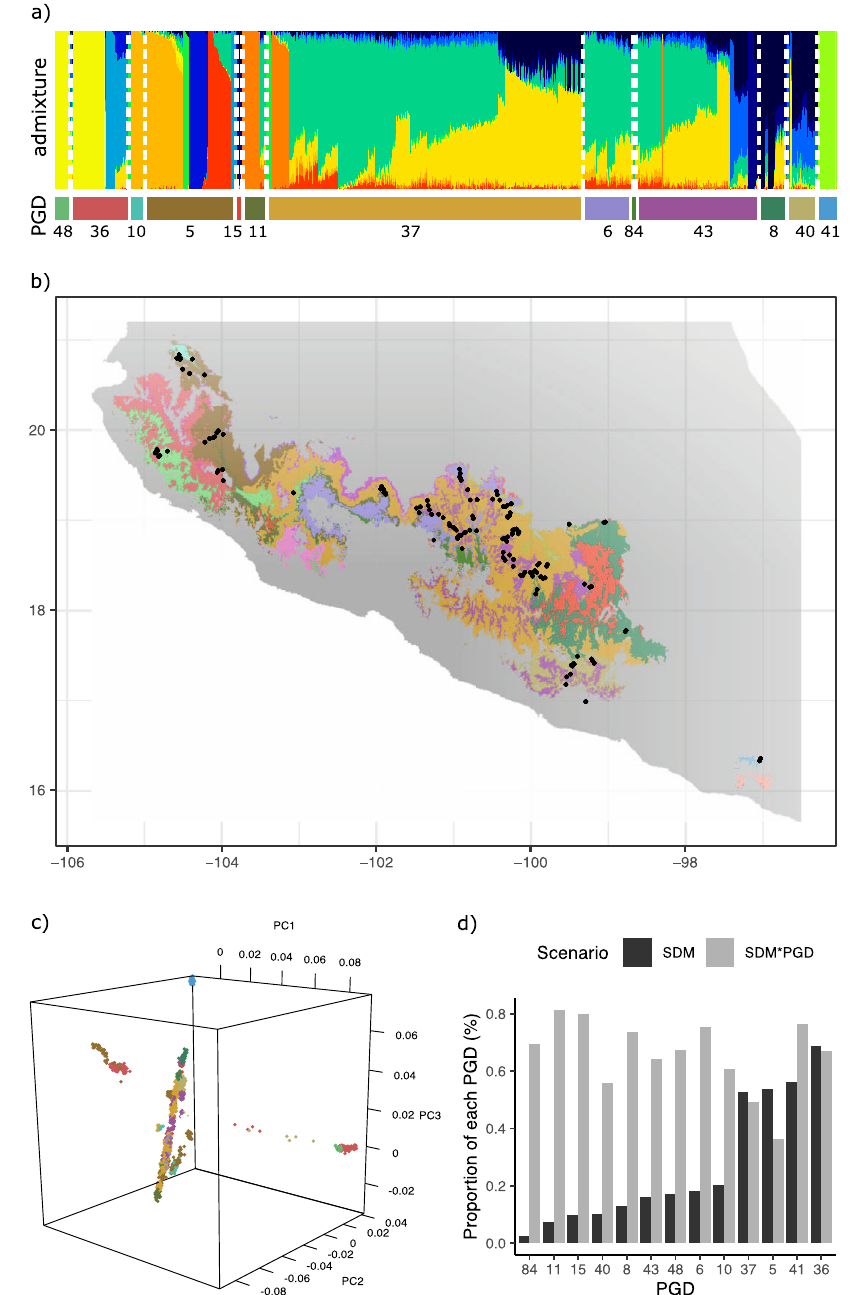
Fig. 3 | Genetic diversity of Zea mays subsp. parviglumis , a maize CWR, repre- sented in the proxies of genetic differentiation (PGD). ( a ) Admixture plot assuming K =13geneticclusters,usingca.30,000SNPs(datafromRivera-Rodrígue z 48 ). Each bar represents the proportion of different genetic clusters (colors) con- forming an individual. White dashed lines separate the proxies of genetic differ- entiation(numbered colored bars below, matching colors in the mapof ( b ),where thesamplesfell.Coloredbarsonlyincludeproxieswithsamplingpointsusedinthe genetic analysis. ( b ) Potential distribution model of Z. mays subsp. parviglumis subdivided by proxies of genetic differentiation (background colors), overlaying thegeographiclocationofindividualssampledforgeneticanalyses(blackdots).( c ) Scoreplot ofa principalcomponent analysis performed with the geneticdata. The fi rst three components are projected. Each point represents an individual colored bytheproxyofgeneticdifferentiationwhereitfellaccordingto( b ).( d )Proportion of the area of each proxy of genetic differentiation represented in the Zonation